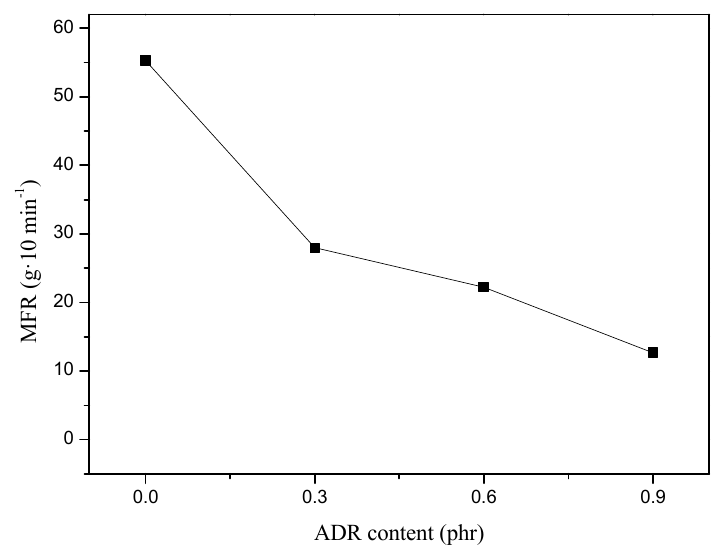
Figure 9. Effect of ADR addition on MFR of PETG/PGA/ADR (65/35/x) samples. The tensile properties of the neat PETG and PETG/PGA/ADR (65/35/x) blends are listed in Table 4. The typical tensile stress–strain curves of these samples are shown in Figure 10. Compared to neat PETG, the PETG/PGA (65/35) blend showed poor tensile ductility, due to a drastic decrease in the elongation at break from 223.0% (neat PETG) to 11.1%. It is worth noting that the elongation at break of the PETG/PGA/ADR (65/35/x) samples increased with an increase in the ADR content. Upon the addition of 0.3 phr of ADR, the elongation at break increased from 11.1% for the binary sample to 123.2%, an increase of 1010%. With the further addition of 0.9 phr ADR, the elongation at break of the ternary sample reached 160.8%. This improvement in tensile ductility could be attributed to the reactive compatibilization effect of ADR on the PETG/PGA interface. On the other